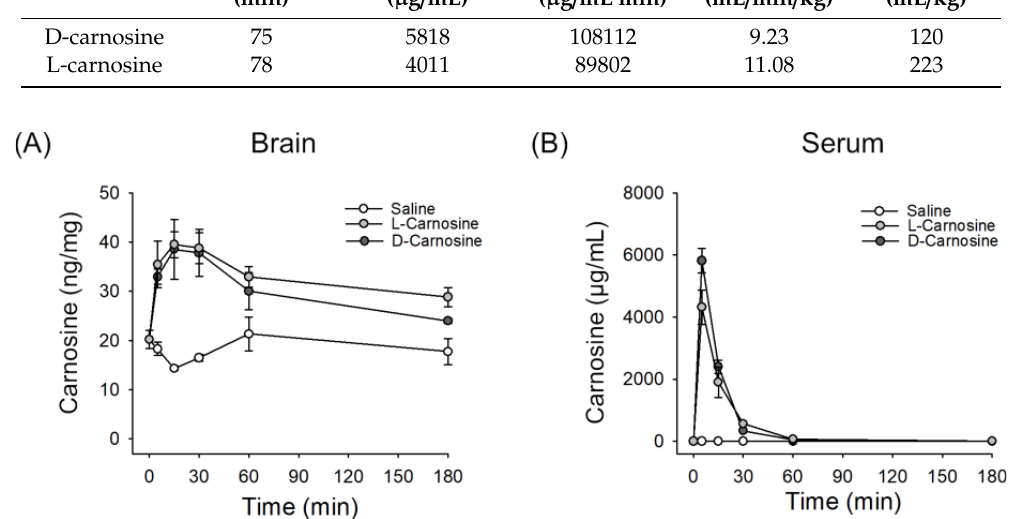
Figure 1. Concentration-time curves of carnosine in brain and serum via intravenous administration in healthy mice; D-carnosine ( n = 4), L-carnosine ( n = 5) and saline ( n = 5). Saline was used as vehicle throughout the study. ( A ) Levels of carnosine measured in brain at different time points (0 to 180 min). ( B ) Levels of carnosine measured in serum at different time points (0 to 180 min). Mean ± SEM.